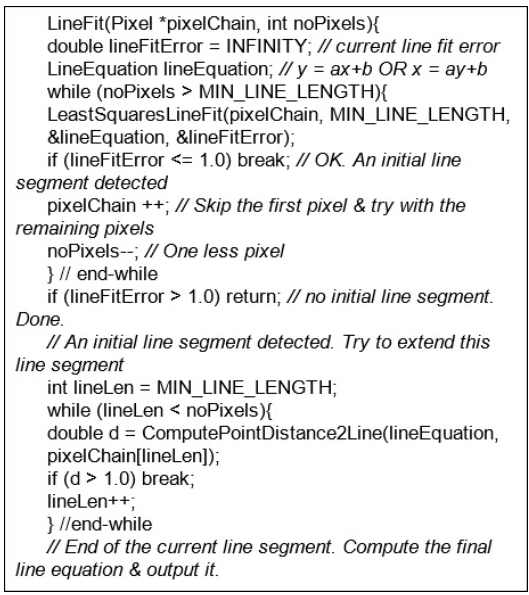
Figure 6: Algorithm to extract line segments from a pixel